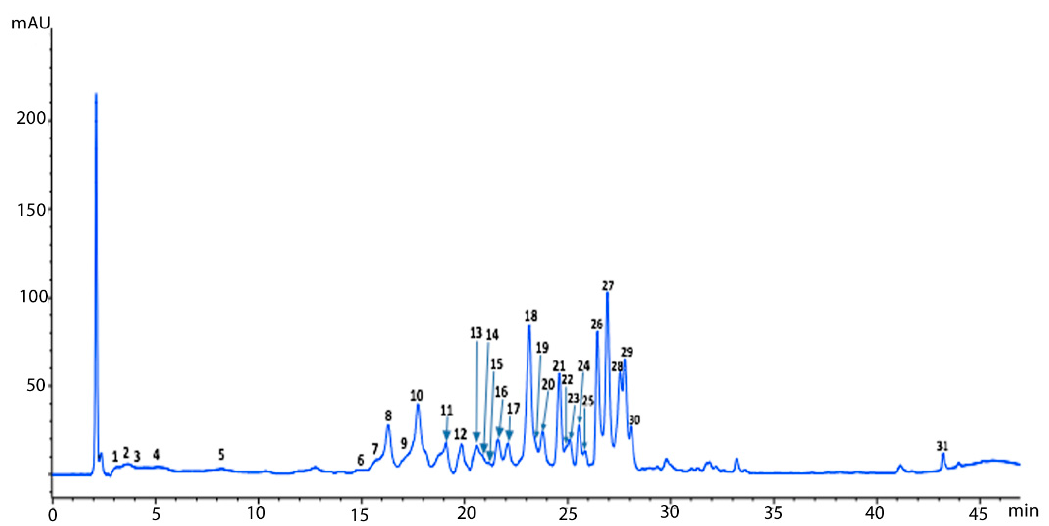
Figure 2. Representative HPLC-PDA trace of Peumus boldus leaf extract obtained with methanol. The trace correspond to the signals recorded at 304 nm. Numbers refers to the compounds listed in Tables 1 and 2. HPLC separation was performed in reverse phase under gradient. Table 1. Alkaloids identified from P. boldus with the high-performance liquid chromatography coupled with Ion Trap mass spectrometry (HPLC-IT-MS / MS) method in a positive ionization mode.